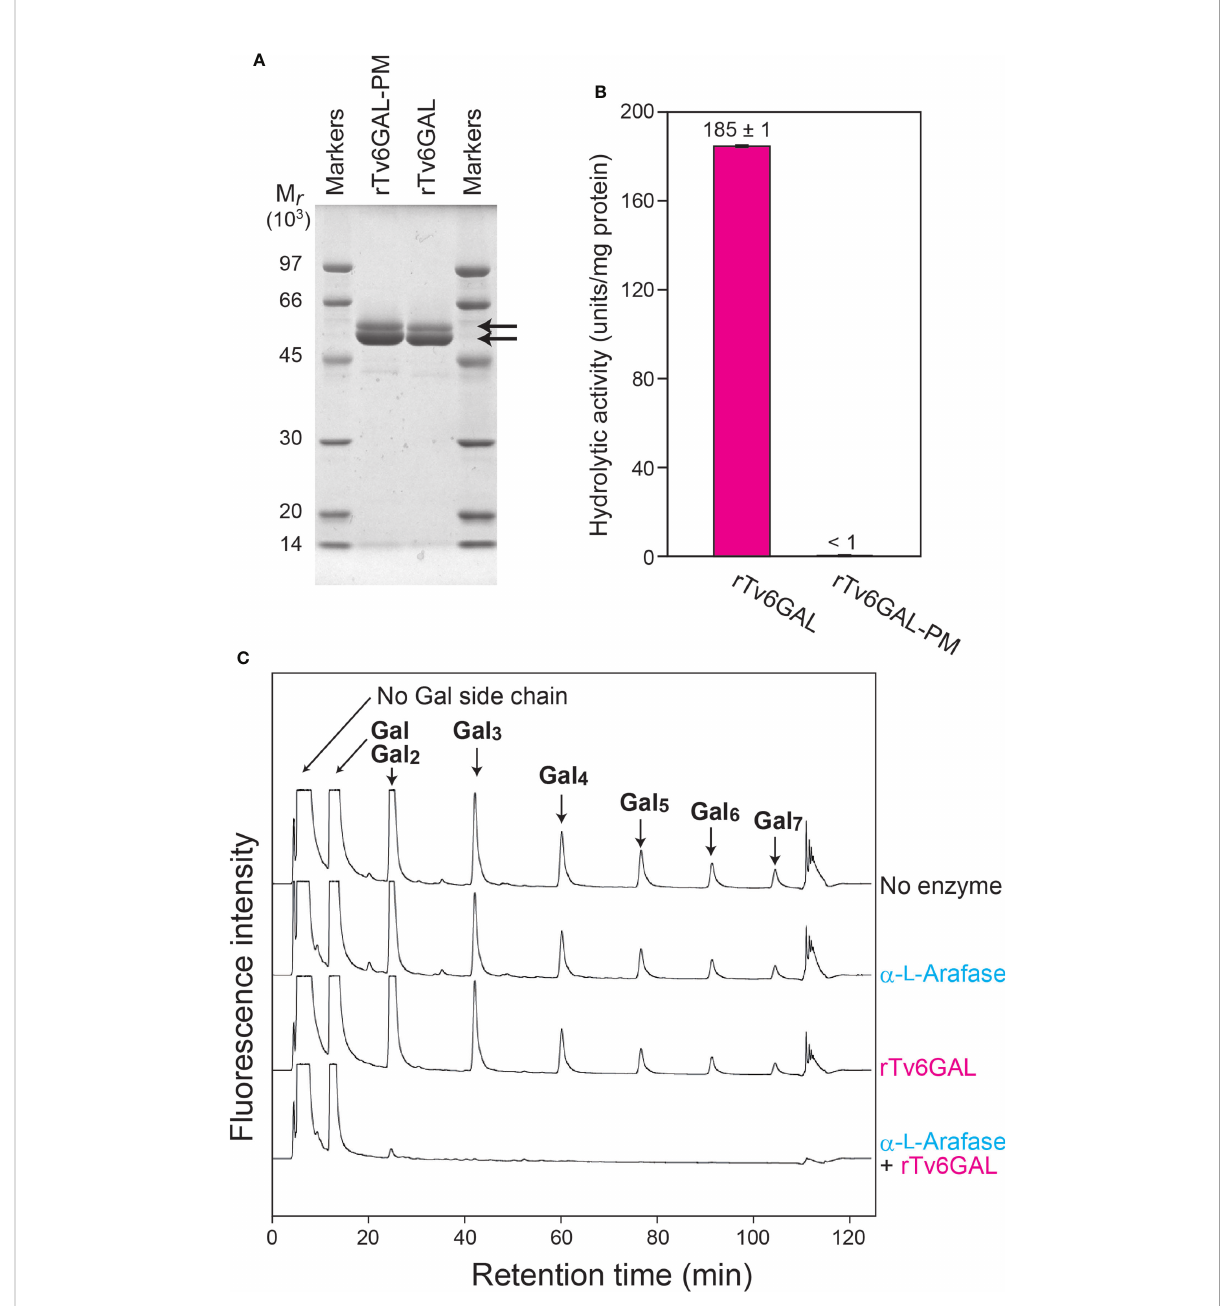
FIGURE 2 In vitro structural modi fi cation of b -1,3:1,6-galactan. (A) The expression of rTv6GAL and rTv6GAL-PM in P. pastoris . The puri fi ed rTv6GAL and rTv6GAL-PM were analyzed on SDS-PAGE. Proteins in the gel were stained with Coomassie Brilliant Blue R-250. Arrows indicate rTv6GAL and rTv6GAL-PM. (B) Hydrolytic activity of rTv6GAL and rTv6GAL-PM toward algal b -1,6-galactan. (C) Change in the length of b -1,6-galactan side chains. b -1,3:1,6-Galactan reacted with rTv6GAL was hydrolyzed into b -1,6-galactooligosaccharides using Il3GAL, NcEn3GAL, AnGlcAase, and a - L-Arafase (Supplementary Figure S2). The resulting mono- and oligosaccharides were derivatized with ABEE and analyzed on HPLC. Note that each b -1,6-galactooligosaccharide has one Gal derived from the b -1,3-galactan main chain. For example, a b -1,6-Gal 2 side chain is detected as 1,6-Gal 3 in this analysis. M r , relative molecular